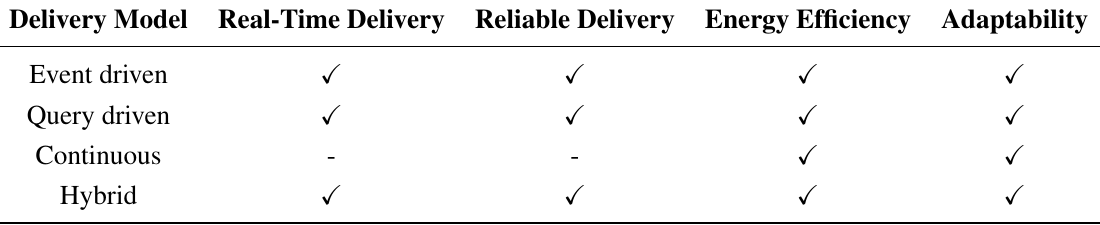
Table 1. Key QoS requirements and metrics for different delivery